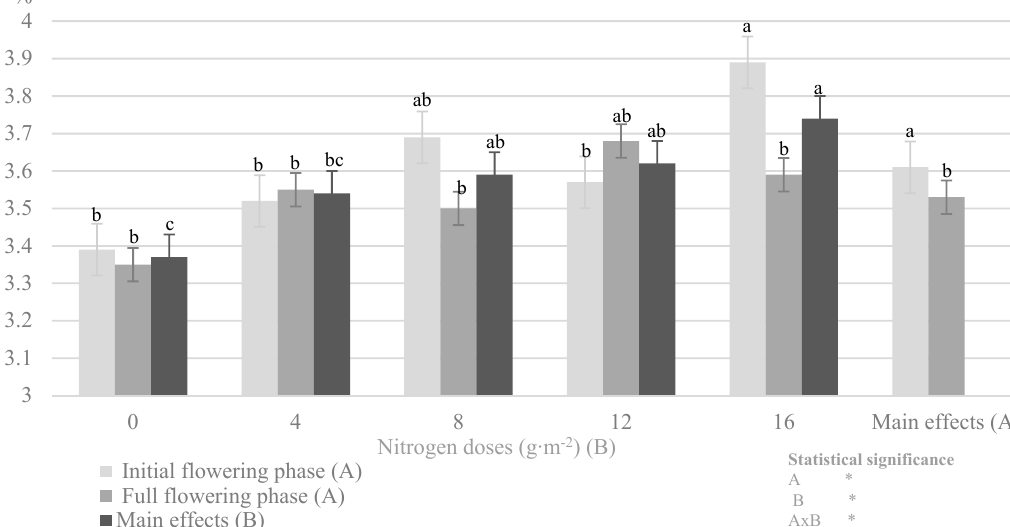
Figure 1. Impact of the nitrogen dose and plant development phase on total nitrogen content in the herb savory cv. Saturn (in 2014–2016) (Note: The results are presented as the mean ± SD; means sharing the same letter on a bars do not differ significantly according to Tukey’s test at p ≤ 0.05; significant effects for the main factors and for interaction between them are indicated with asterisks (*); n.s.—no significance).